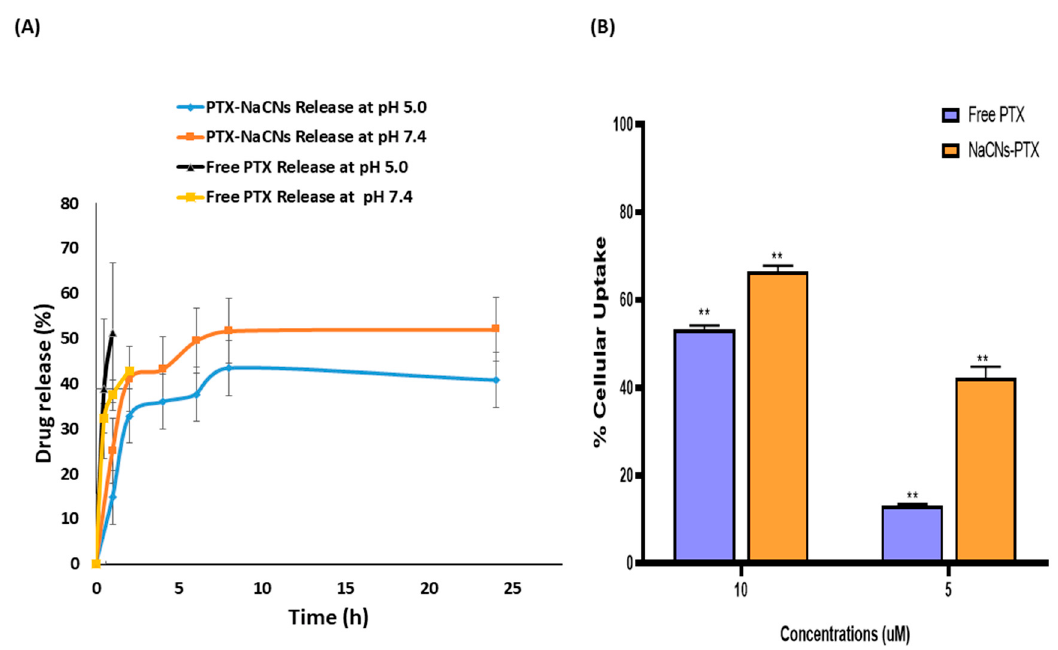
Figure10. ( A )In vitroreleaseprofileofPTX-NaCNsatpH5.0and7.4, asseenbyusingaTube-O-dialyzer ( B ) Cellular uptake of free PTX and PTX-NaCNs by MCF-7 cells at 5 and 10 µ M following 4 h of treatment. The values were extremely significant (**) ( p < 0.0001) at CI of 95% vs. free PTX